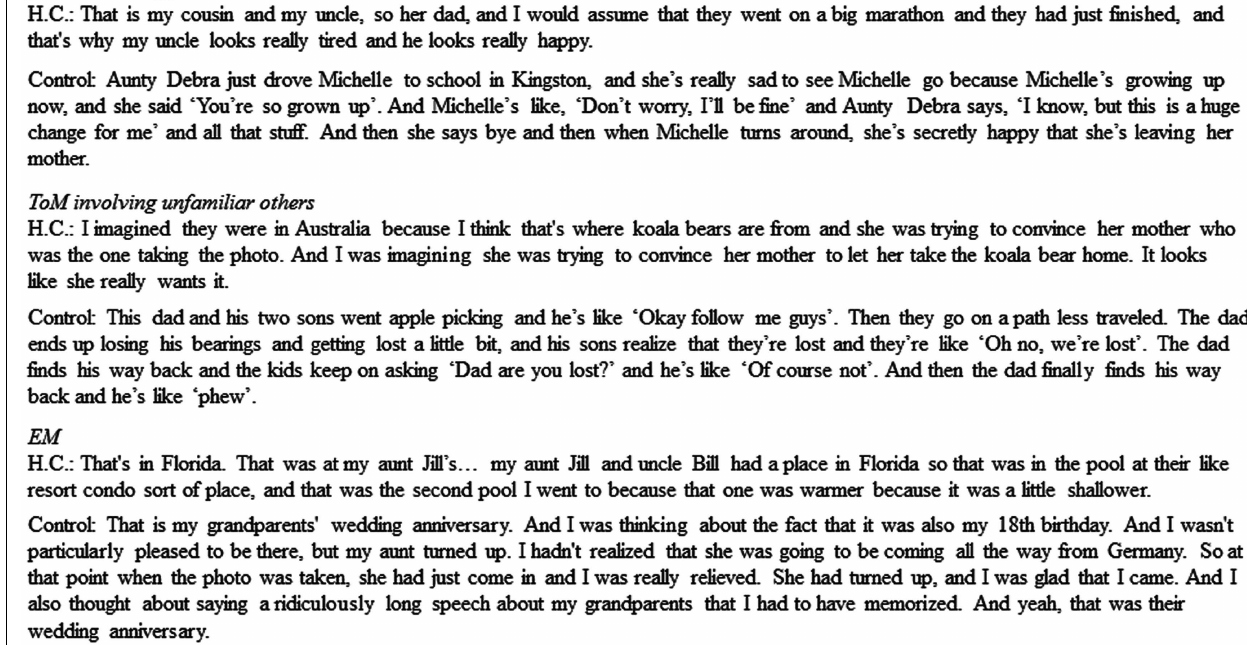
FIGURE 3 | Representative samples of the pToM,ToM, and EM narratives provided by H.C. and a control